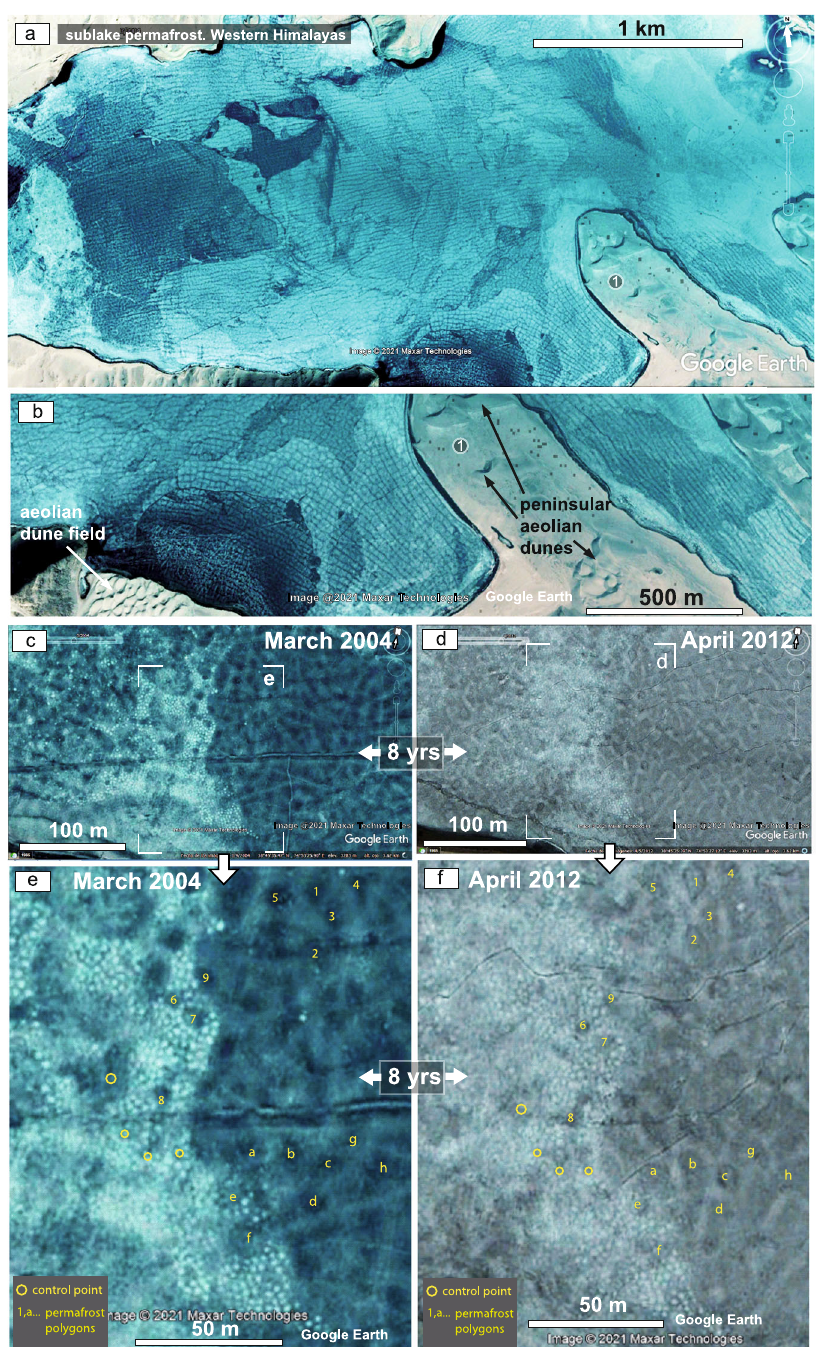
Fig. 3 | Persistent permafrost in the Qiongkuai Lebashi Lake, Xinjiang Uygur Autonomous Region, China. a Evidence of widespread sublake permafrost poly- gon network visible through clear lake ice. b Note how fractures within lake ice do not affect the underlying permafrost polygon pattern. c – f Evidence of sublake permafrost patterned ground persisting for 8 yearsin the lake . c , Satellite imagery fromMarch2004,and d satelliteimageryfromApril2012showingthesameareaof